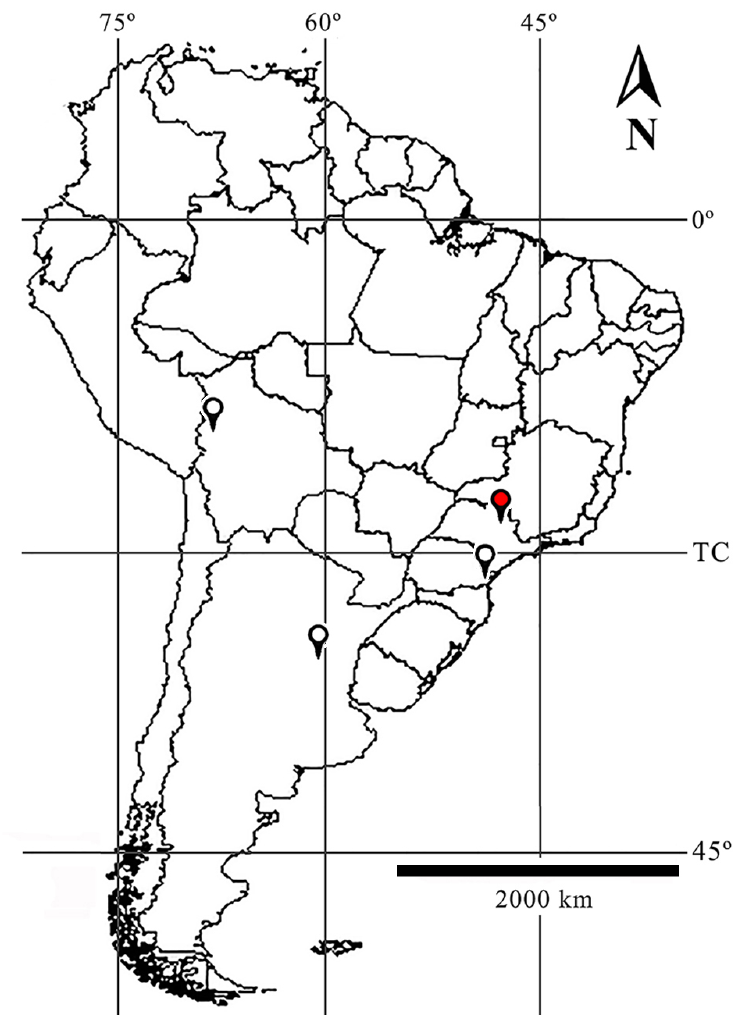
Figure 4. Map indicating the known occurrences of Gasteruption helenae Macedo, 2011 (black dots with white marks) and the new record of distribution (black dot with red mark). TC = Tropic of